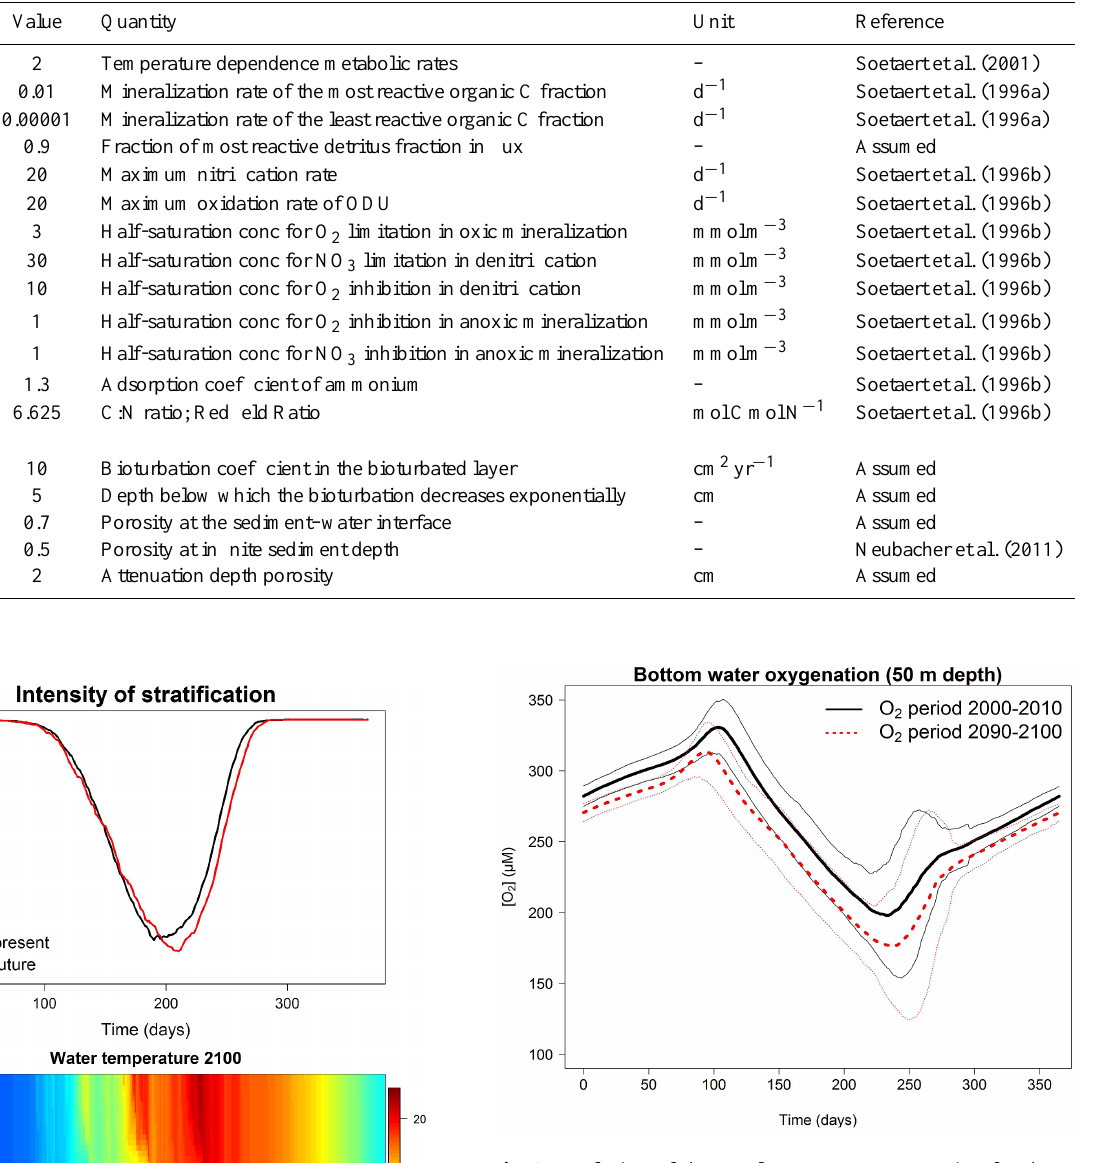
Fig. 9. Evolution of the yearly oxygen concentration for the pe- riod 2000–2010 (black solid line) and period 2090–2100 (red dot- ted line) at the bottom layer of the Oyster Grounds. The curves are the average value of the 16 simulations for each period. The 95% confidence interval is also